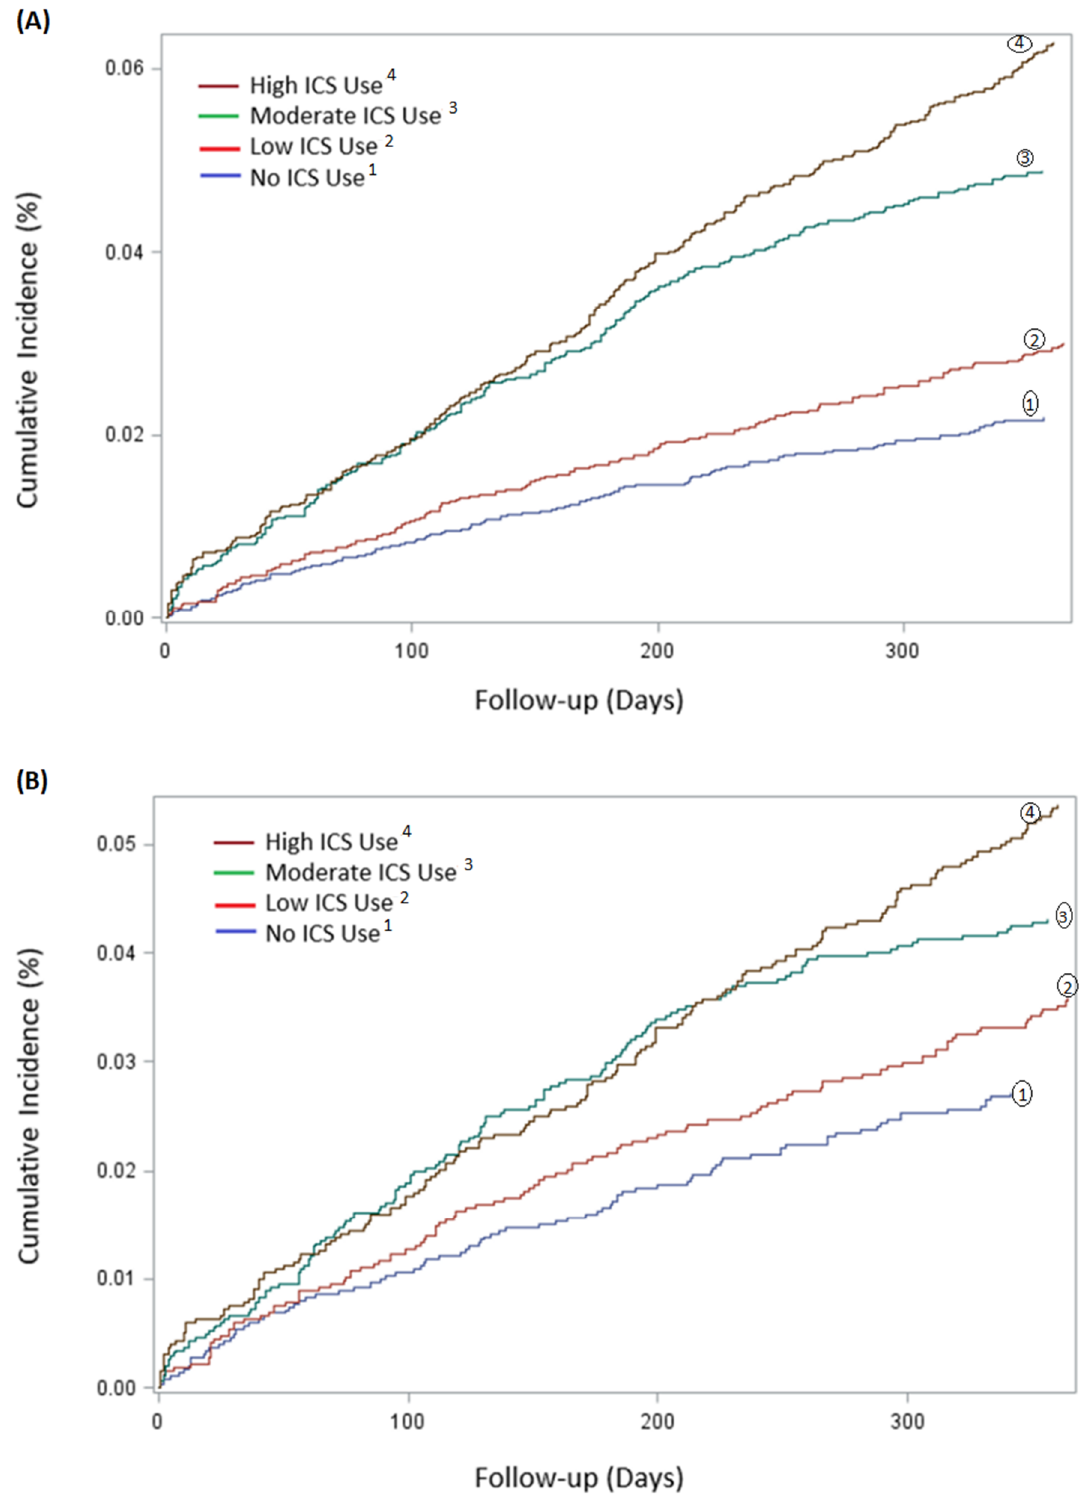
Figure 3. Cumulative incidence, in percentage (%), of H. Influenzae during first 365 follow-up days after cohort entry, categorised according to different accumulated doses of ICS . ( A ) Cumulative incidence of 21,218 patients, categorised in the following four ICS groups: no ICS use, low ICS dose, moderate ICS dose and high ICS dose. ( B ) Cumulative incidence of 13,324 matched patients, categorized similarly as above.